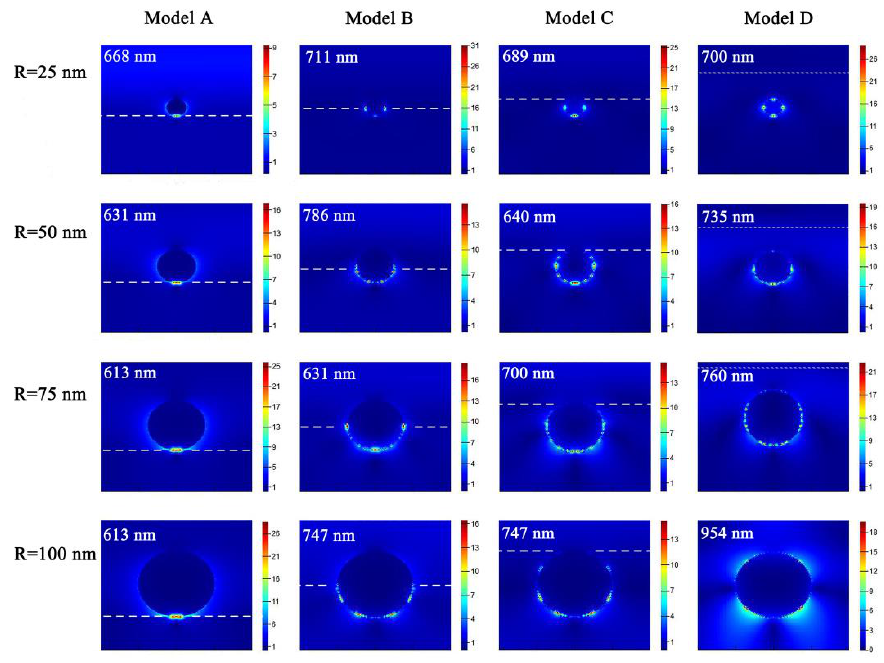
Figure 5. The distribution of the strongest local enhanced electric field of Au nanospheres loaded on the TiO 2 substrate in the whole simulation region of 300–900 nm. The dashed line represents the interface between the Au nanospheres and the TiO 2 substrate.